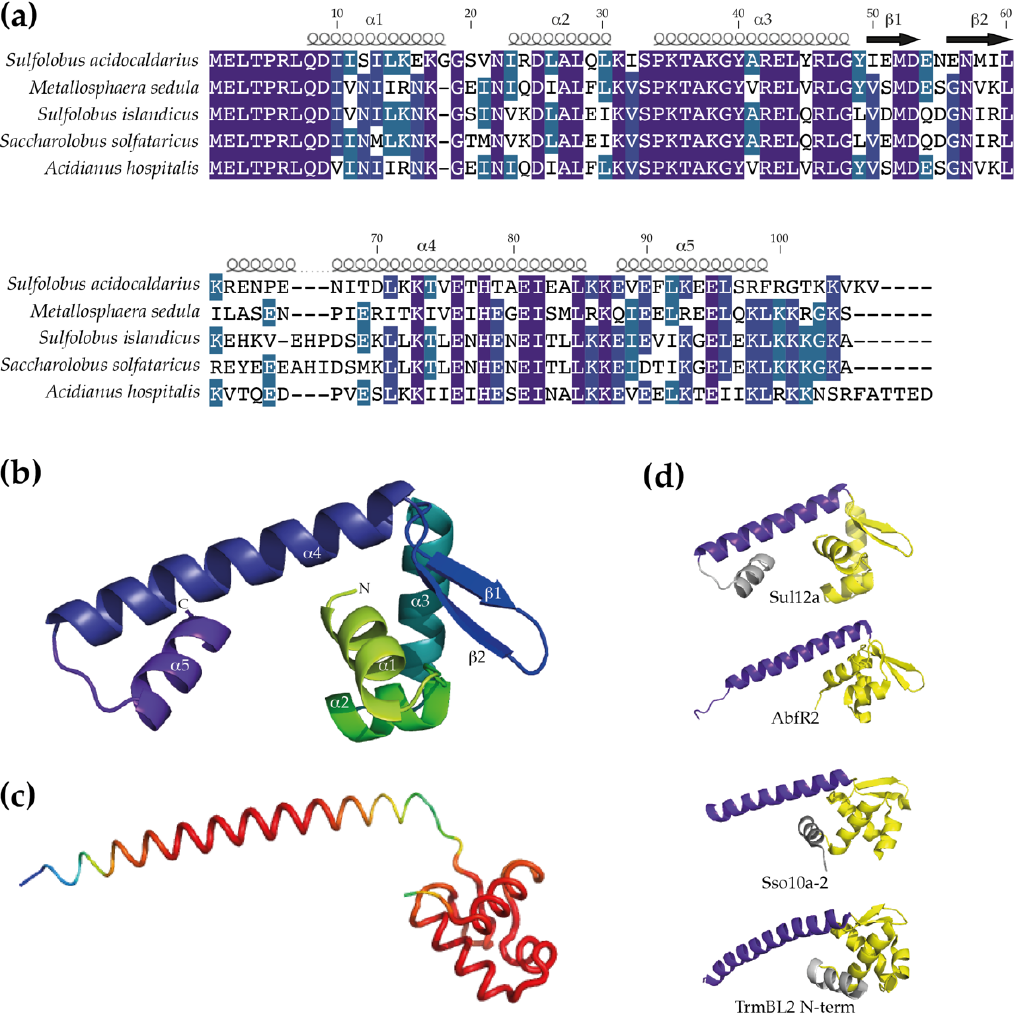
Figure 2. Prediction of the monomeric Sul12a structure. ( a ) Sequence alignment of Sul12a homologs with indication of predicted secondary structure elements. Position numbering is based on the S. acidocaldarius Sul12a protein. Pairwise sequence identities and similarities with Sul12a are as follows: 57% and 74% for the M. sedula homolog, 59% and 78% for the S. islandicus homolog, 58% and 76% for the S. solfataricus homolog and 60% and 79% for the A. hospitalis homolog. ( b ) Cartoon representation of a homology model of Sul12a, predicted by Phyre2 [19]. This model is based on the crystal structure of the HTH-containing hypothetical protein Sso2273 from S. solfataricus (PDB 2X4H) and was selected based on the highest coverage (89%) and confidence score (94.72%) of all models. ( c ) Cartoon representation of a model of the Sul12a structure predicted with AlphaFold [21]. Coloring is according to B-factors, with red depicting higher reliabilities than green and blue. ( d ) Comparison of monomeric structures of Sul12a of S. acidocaldarius (model presented in panel ( b )), Sso10a-2 of S. solfataricus (PDB 4HW0), AbfR2 of S. acidocaldarius (PDB 6CMV) and the N-terminal domain of TrmBL2 of P. furiosus (PDB 5BPI). The core wHTH motif is colored yellow, the dimerization helix purple and additional α -helices are colored grey. The grey α -helix shown for Sso10a-2 is connected to the wHTH motif; this structure is entirely modeled.